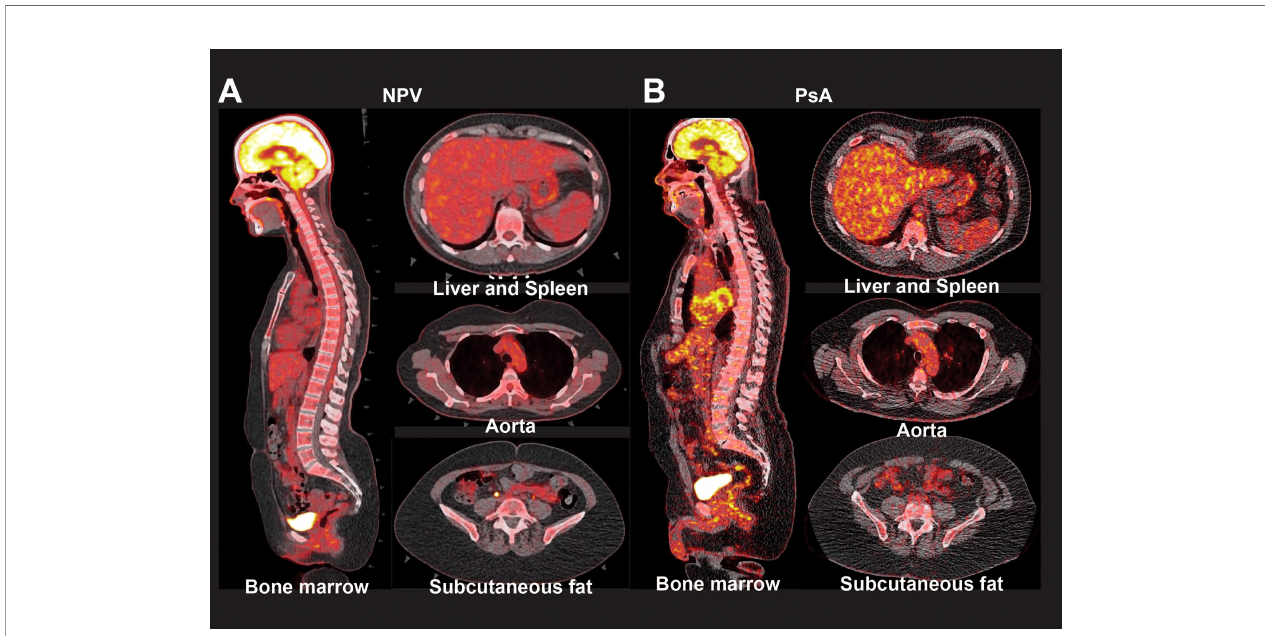
FIGURE 2 | Radiographic markers of in fl ammation in patients with psoriatic arthritis. Representative PET-CT images show FDG uptake in the bone marrow, liver, spleen, aorta, and subcutaneous fat of non-psoriatic volunteers (NPV, A ), and patients with psoriatic arthritis (PsA, B